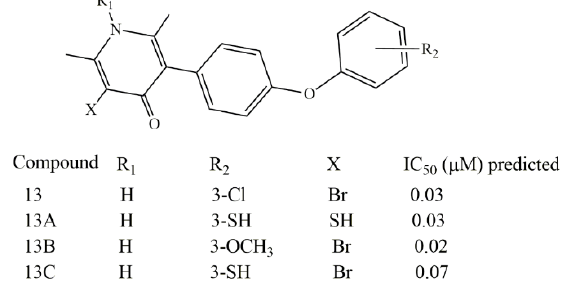
Figure 4. New possible small structure modification on the compound 13 and predicted IC 50 values.